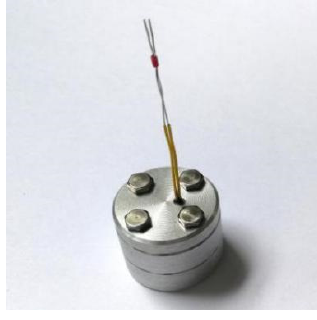
Figure 31. Assembled microexplosive train test tooling.